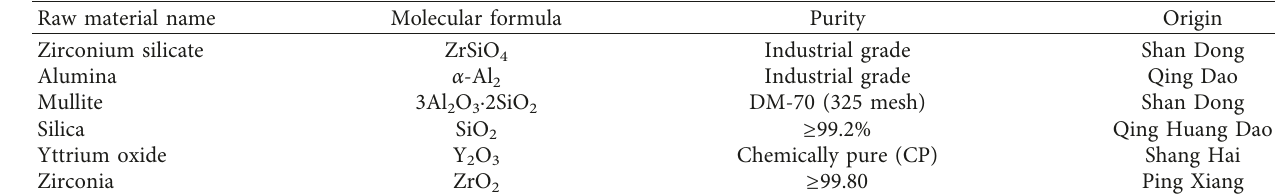
Table 1: Raw materials used in experiments.